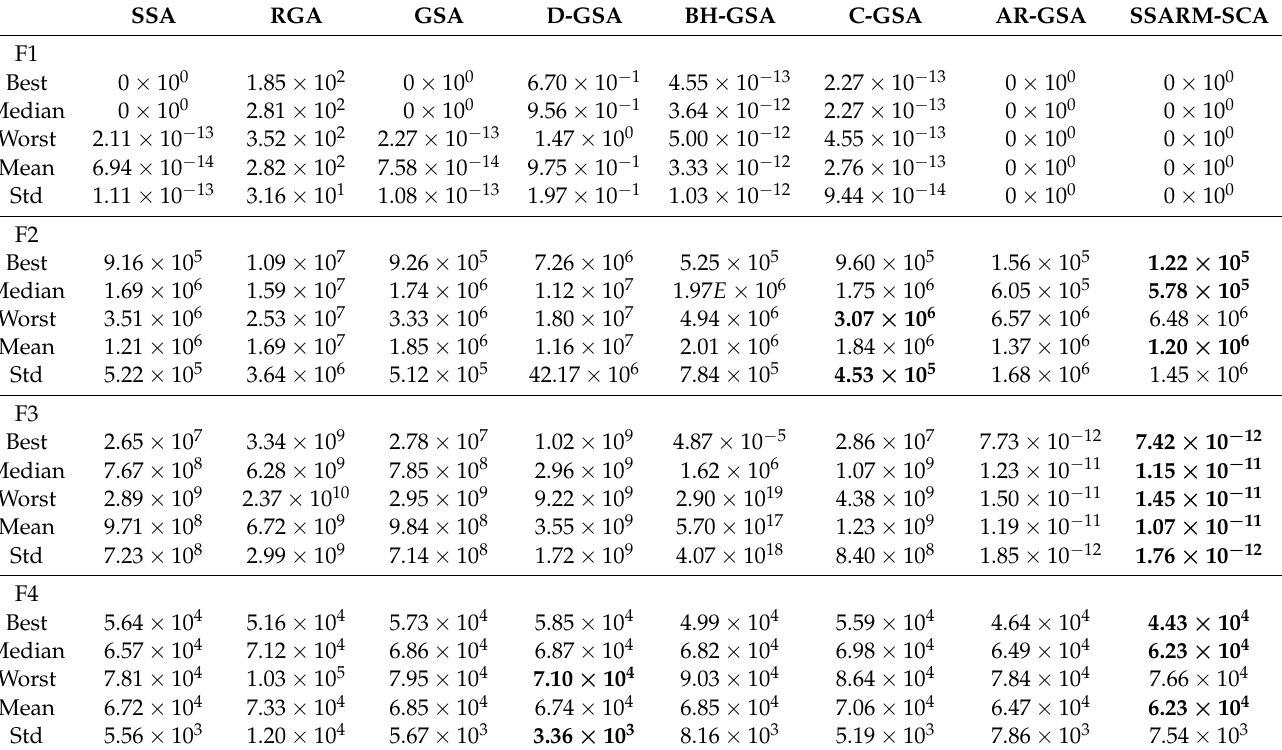
Table 2. Comparative analysis between SSARM-SCA and other SOTA methods for CEC2013 uni- modal